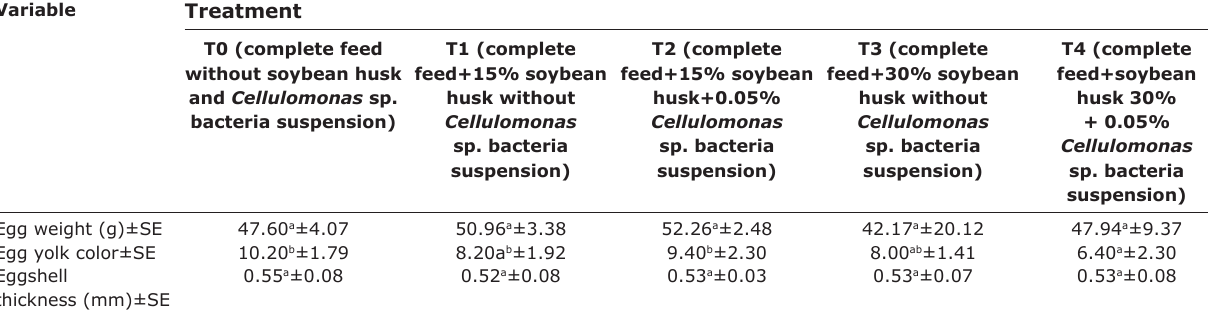
Table-4: Mean and standard deviation of egg weight, egg yolk color, and egg shell thickness of duck.